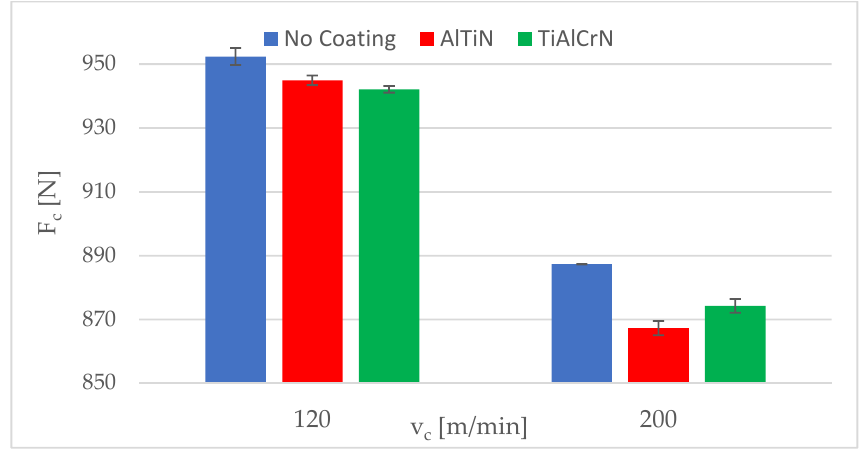
Table 9. Estimation for paired difference and test statistics.